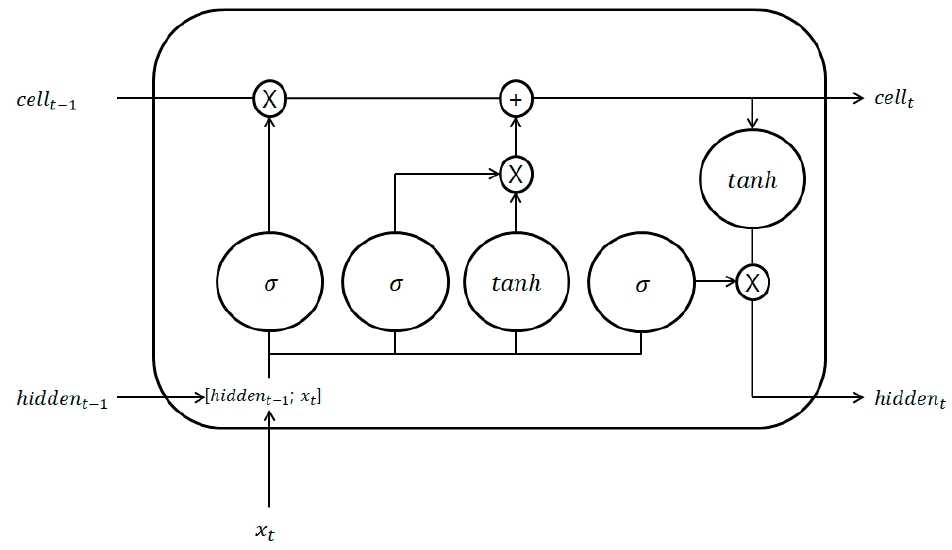
Figure 4. The structure of BiLSTM.